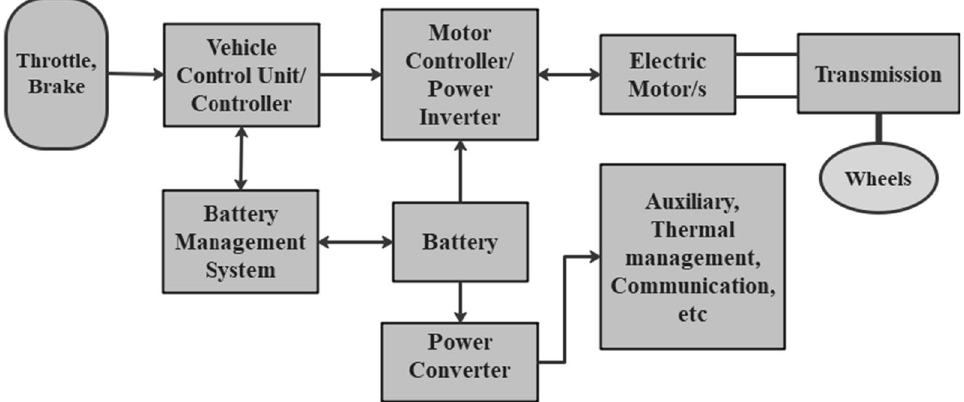
Fig. 1 Typical BMS operation inside an electric powertrain